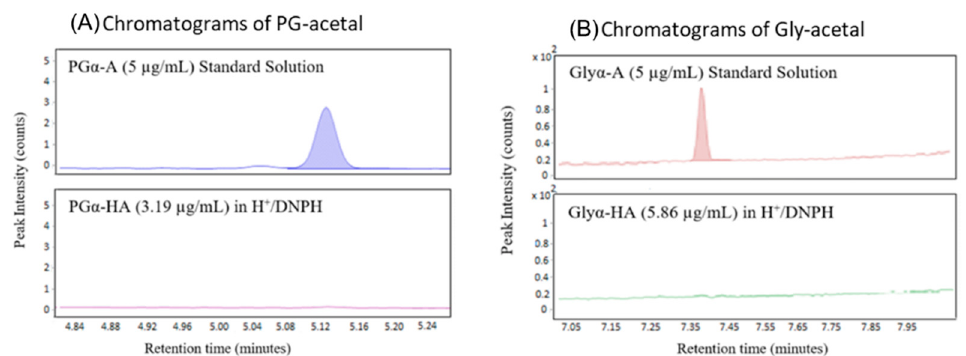
Figure 4. Comparison of chromatographic traces for PG-A ( A ) and Gly-A ( B ): DNPH fortified with PG α -HA and Gly α -HA (bottom) vs. standard solutions of FA-acetal adducts (top). FA-acetal adducts were analyzed by GC–MS, as described in the Analytical Method subsection.